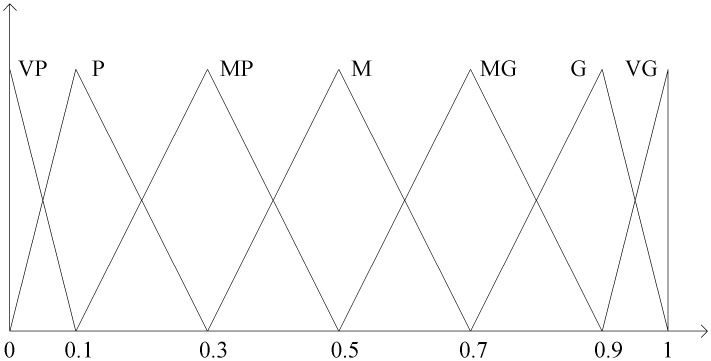
Fuzzy linguistic assessment variables [52].